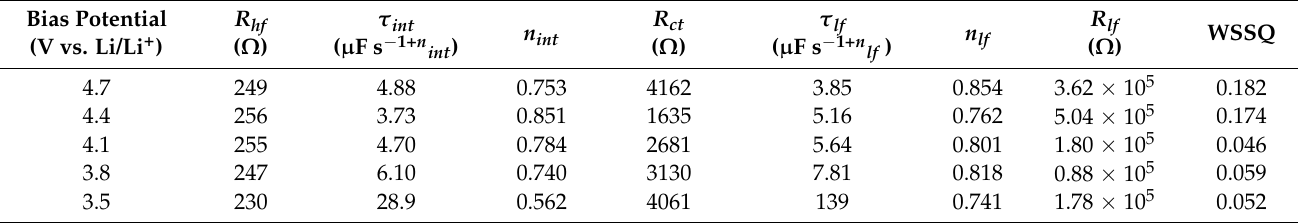
Table A2. Parameters obtained from fitting of experimental EIS spectra shown in Figure 3c,d and Figure 4b to the equivalent circuit depicted in Figure 1b. In addition, weighted sum of squares (WSSQ) value of each fit is presented. Resistance and capacitance values were normalized to 1 cm 2 of electrode